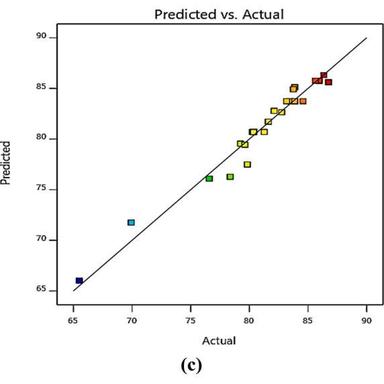
Plots of (a) 3D surface in dark condition; (b) 3D surface in light irradiation; (c) predicted vs. actual values for dye removal response.